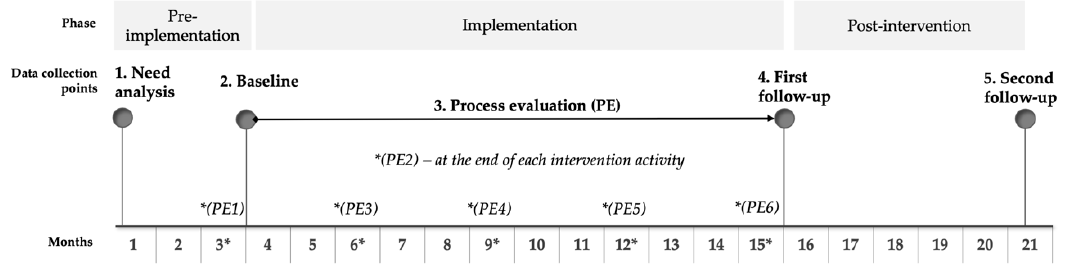
Figure 1. The H-WORK Study Design Overview.